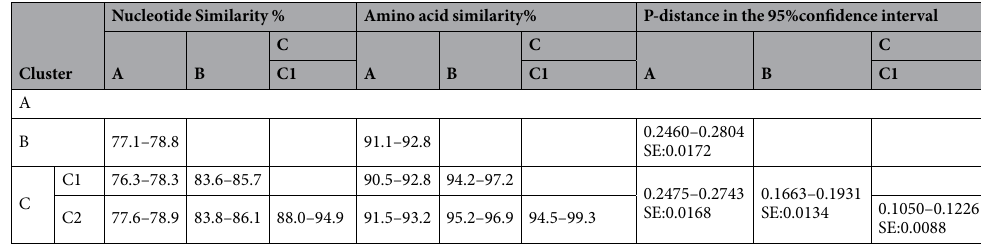
Table 2. The nucleotide (deduced amino acid) similarity and the P-distance between groups (sub-groups) were calculated. The similarity data was shown in the first two parts. Another is the P-distance between groups (subgroups) in the 95% confidence interval. And the standard error was shown below each